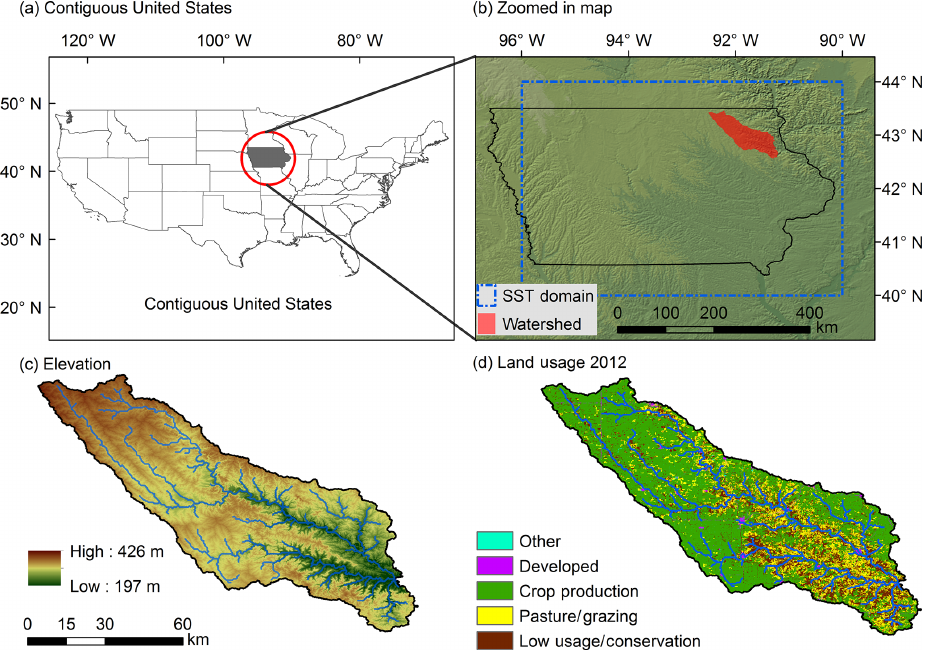
Figure 1. Study region. (a) Contiguous United States with the state of Iowa highlighted in grey. (b) Zoomed-in map showing Iowa (black outline) and the Turkey River watershed (red) and the extent of the stochastic storm transposition region (blue dashed line). (c, d) The Turkey River watershed showing land surface elevation (based on the USGS National Elevation Dataset) and land use (based on the USGS 2012 NLCD), respectively. Table 1. Overview of HBV model parameters and upper and lower parameter limits used for